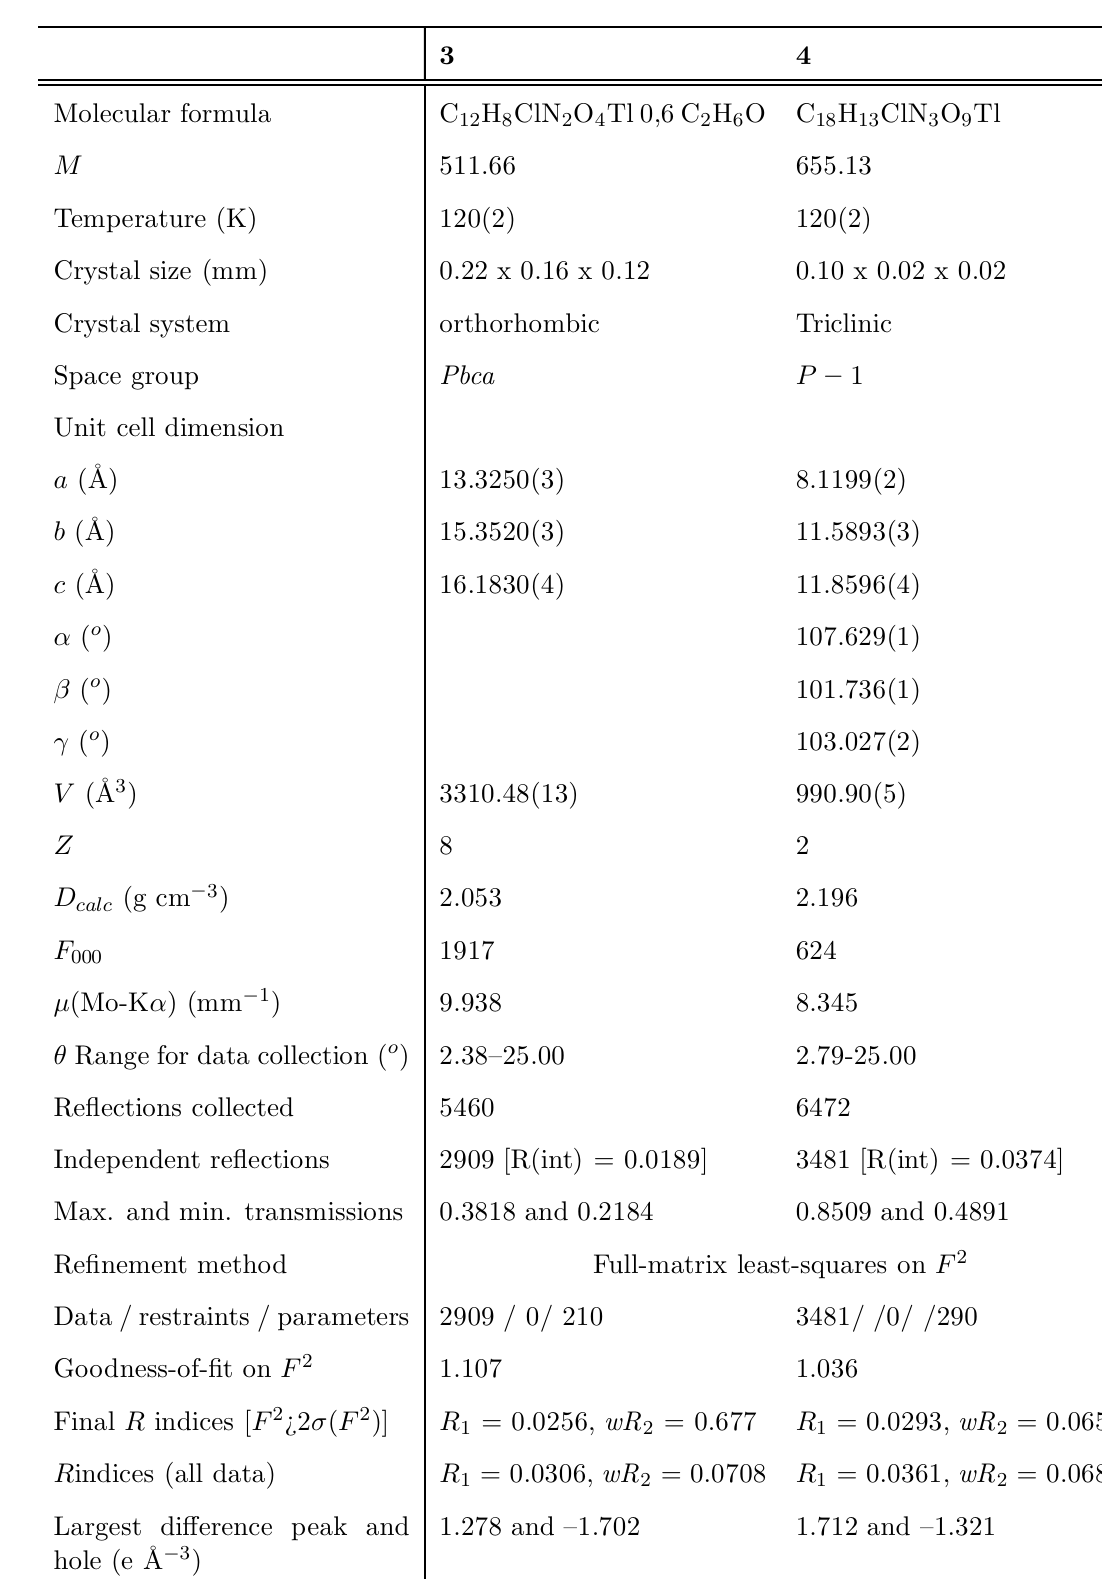
Table 3 Crystal data and details of structure re› nement for [TlCl(inic) 2 ] ¢ 0.6C 2 H 5 OH ( 3 ) and [TlCl(3hpic) 2 (H3hpic)] ( 4